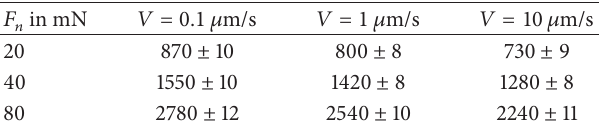
Table 1: Penetration depth measured for different scratching speeds and different load applied.